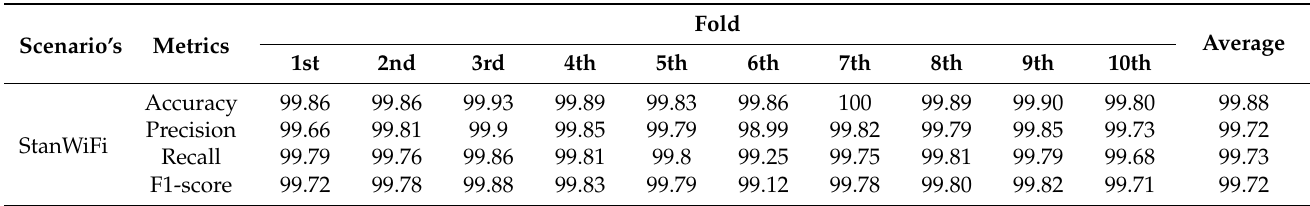
Table 4. Performance result of the proposed STC-NLSTMNet model on the StanWiFi dataset.